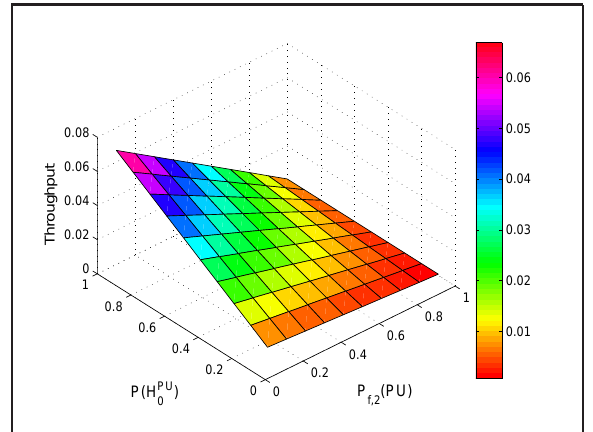
Figure 7. Effect of miss rate probability of CG and PU on the Throughput of CRN